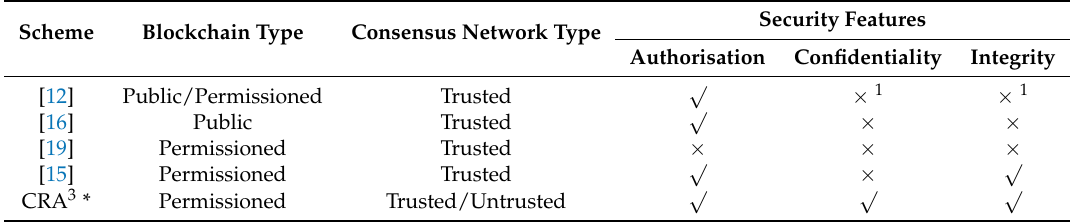
Table 1. Comparison of the security features in different blockchain-related authorisation